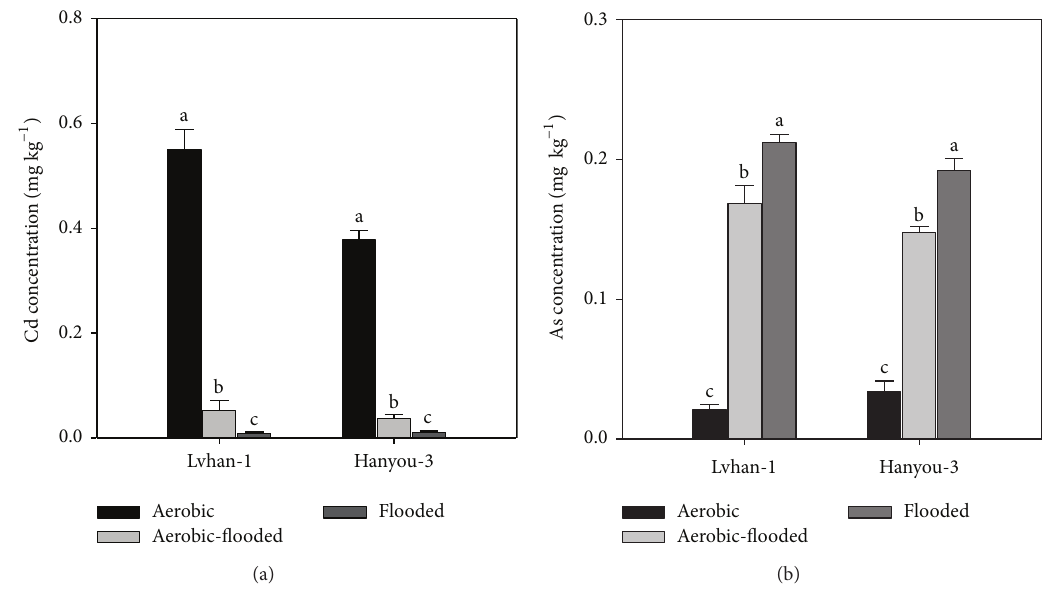
Figure 2: The Cd and As concentration in grains of Lvhan-1 and Hanyou-3 grown under three water management, aerobic, flooded, and aerobic-flooded cultivation in a field experiment. Error bars represent standard error of mean